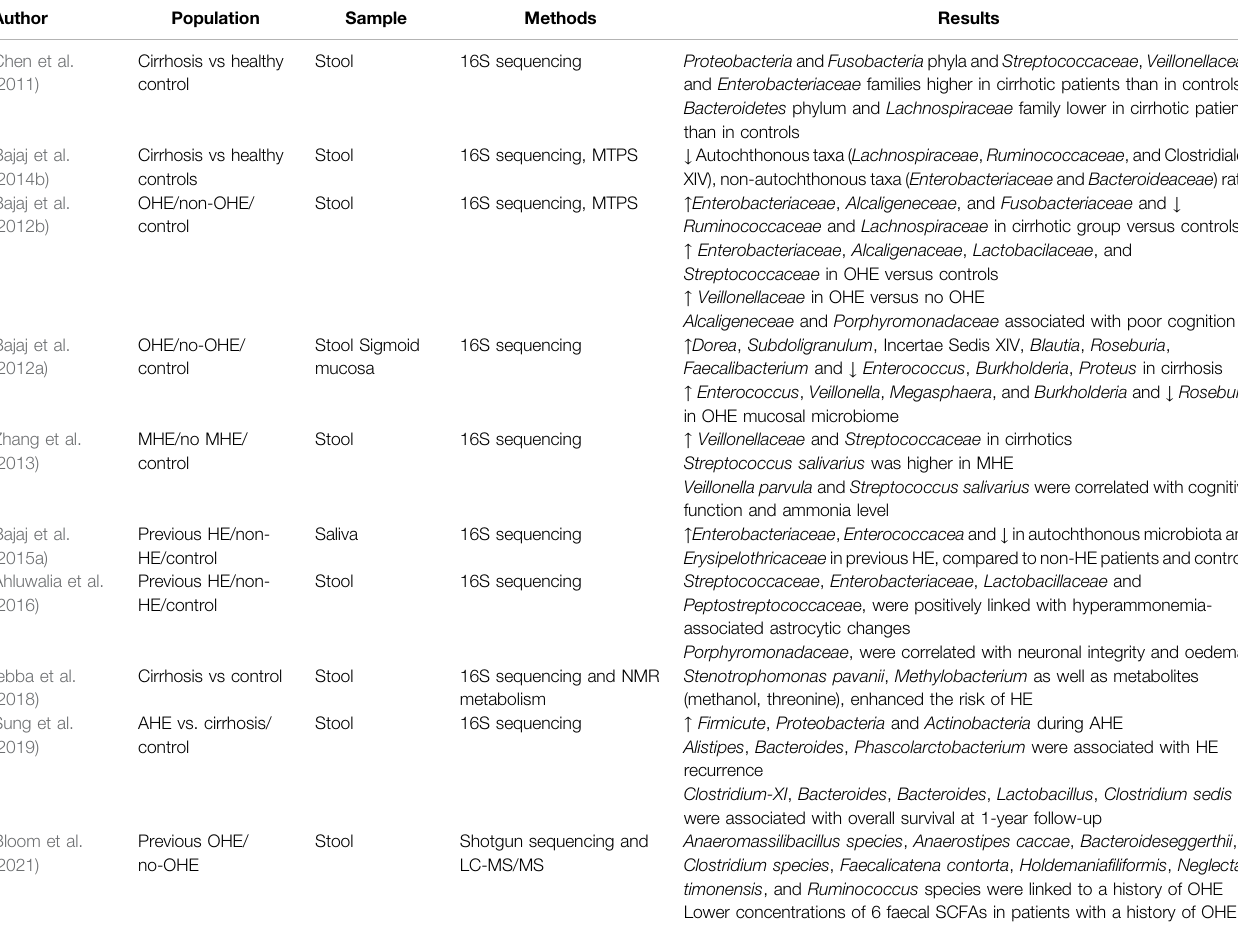
TABLE 2 | Culture-independent studies on gut microbiome in human cirrhosis with or without